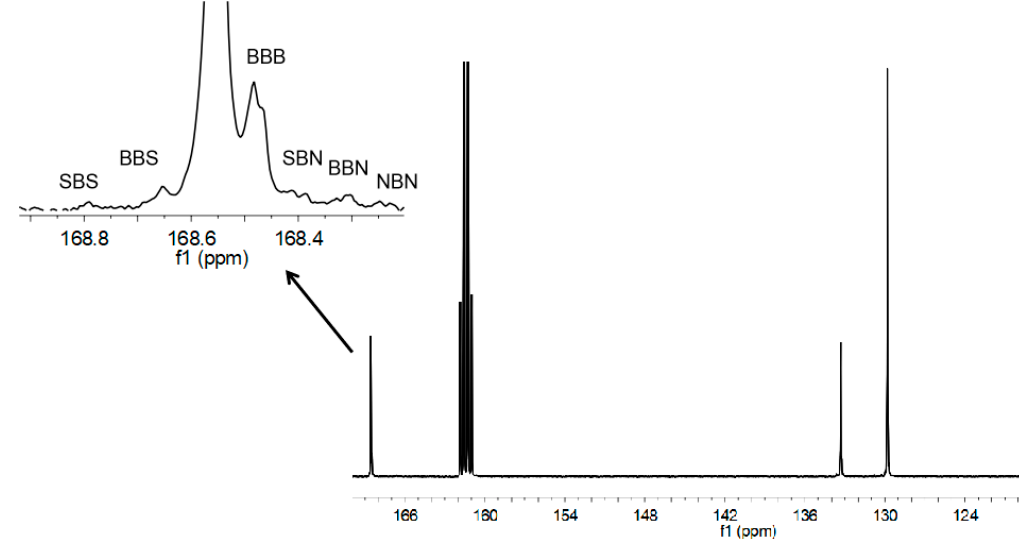
Figure 4. 13 C-NMR spectra of ENCDP-0.